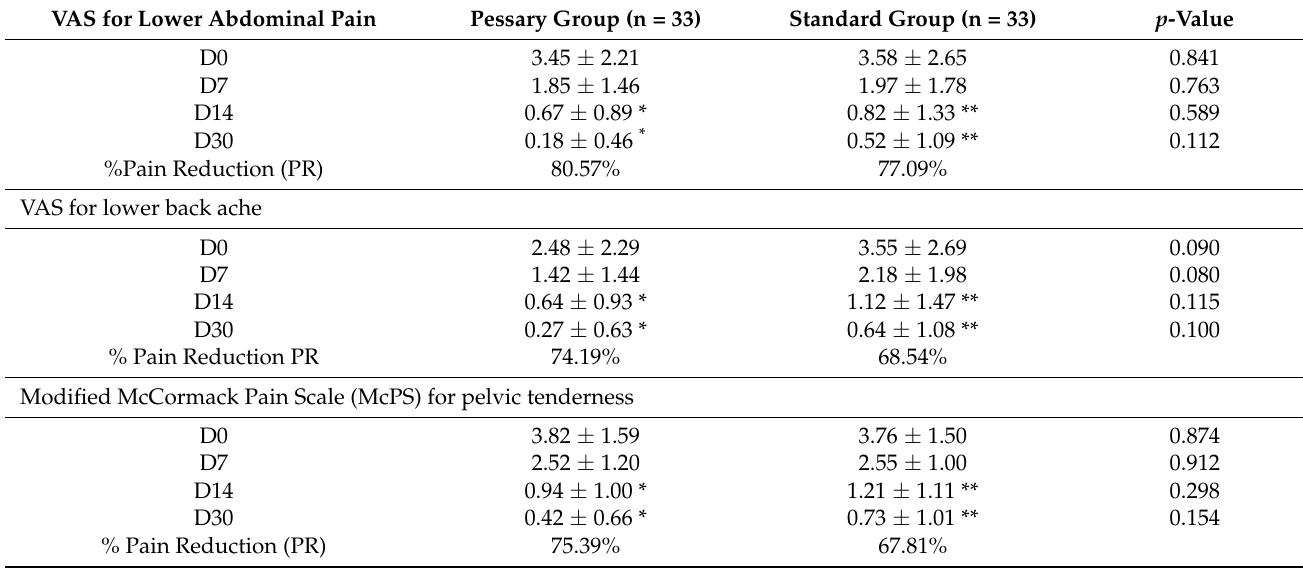
Table 4. The primary outcome measure based on VAS score for lower abdominal pain, lower backache (LBA), and Modified McCormack (McPS) for pelvic tenderness.